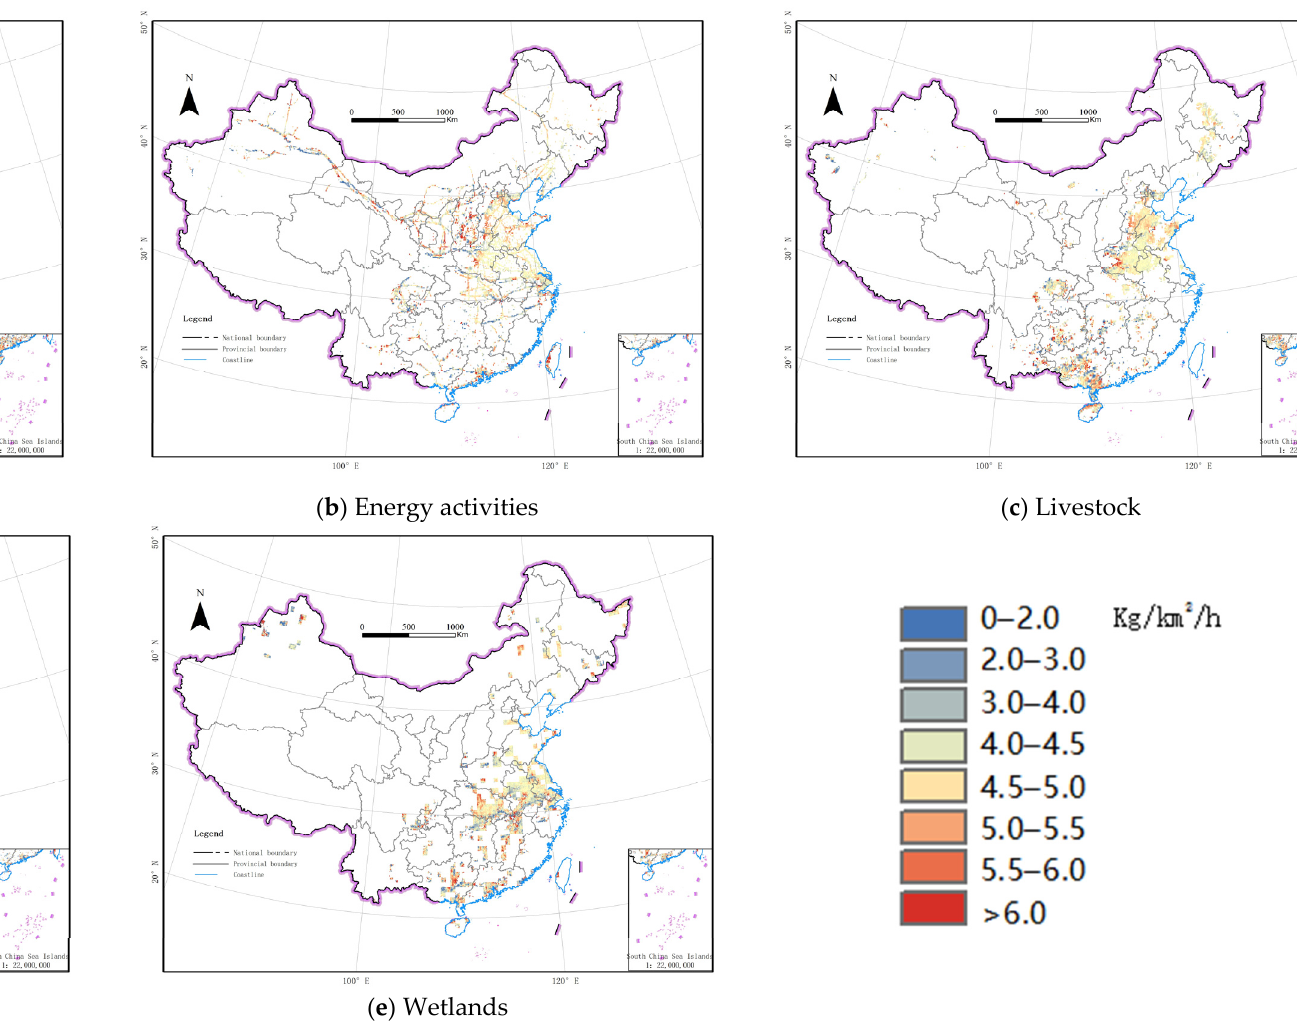
Figure 5. Spatial distribution of CH 4 emissions from five source sectors in China.